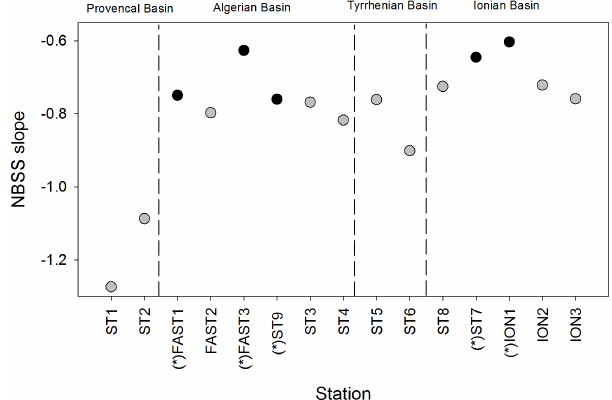
Figure 6. Normalized biomass size spectrum (NBSS) of mesozoo- plankton at ION1. Black dots show the normalized biomass values in the successive size classes, and the straight line represents the linear regression, giving the slope value.